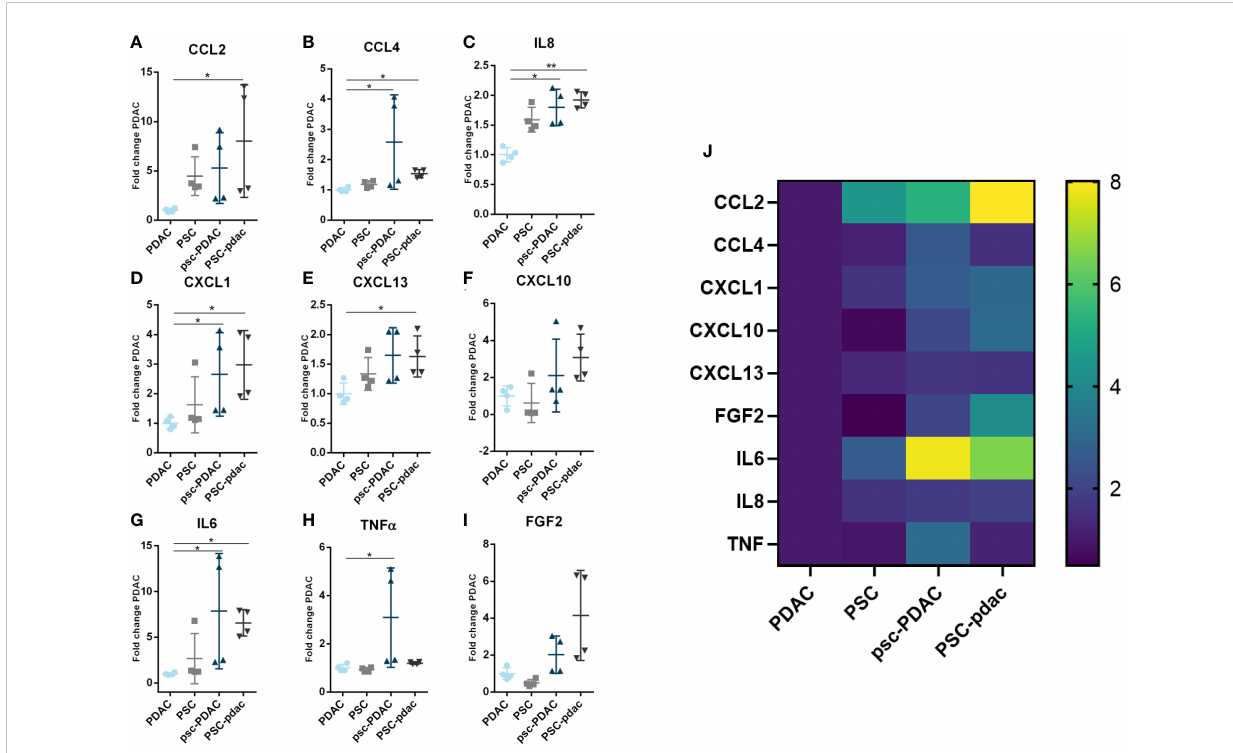
FIGURE 4 Soluble factors secretion: (A – I) Fold change of concentration of chemokines from the medium that was harvested from several culture setups. Samples were obtained from the following conditions: PDAC organoids grown in the bottom lane (in absence of PSCs), PSC grown in the bottom lane (in absence of PDAC, organoids), psc-PDAC samples were collected from the PDAC organoids grown in the bottom lane (in presence of a PSC compartment in the middle lane), PSC-pdac were collected from PSC grown in the middle lane (in presence of PDAC organoids growing in the bottom lane). (J) Heatmap of Luminex data for concentration fold changes. Luminex data was analyzed using Magpix. Samples were taken from the lane, that is depicted in capital letters. CCL2, CXCL1, CCL4, CXCL10, IL-6, IL-8, TNF a , CXCL13, FGF2, IFNy and IL-10 concentrations were measured in the supernatant